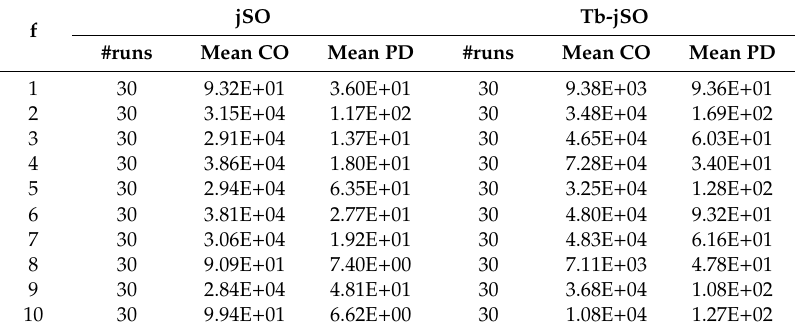
Table 34. Clustering and population diversity of jSO and Tb-jSO on the CEC2020 in 20 D